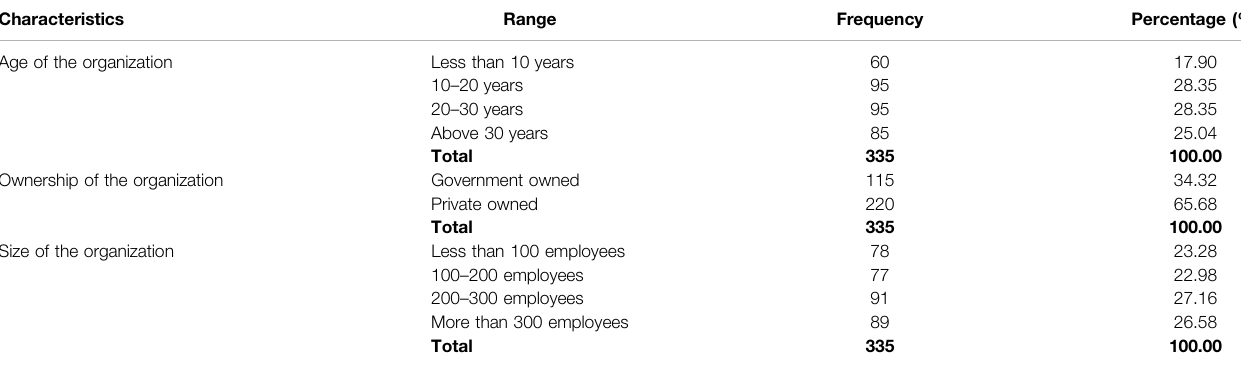
TABLE 1 | Characteristics of the